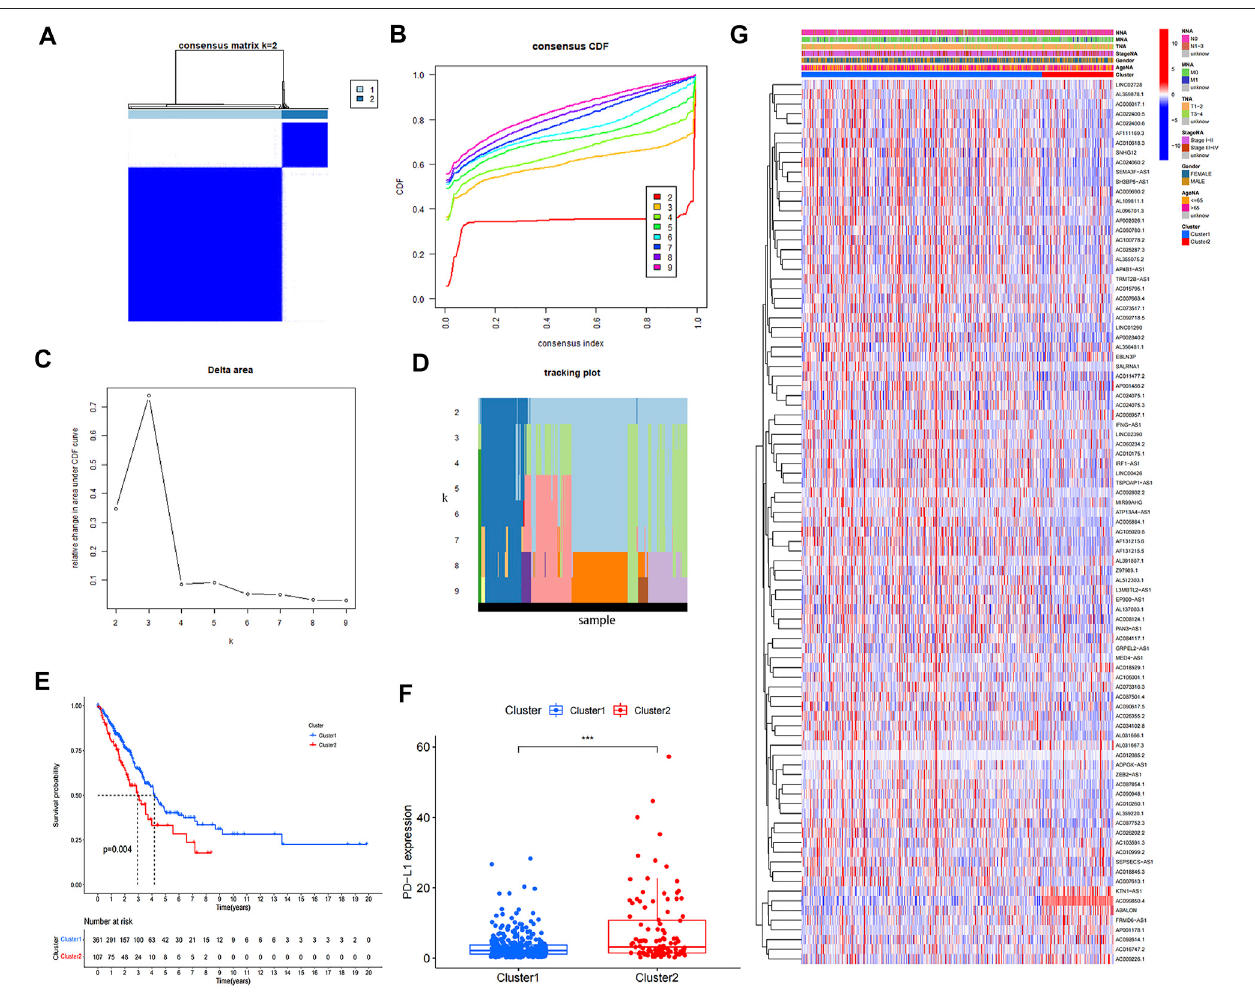
FIGURE 2 | Consensus clustering of prognostic m6A-related lncRNAs. (A) Consensus clustering matrix for k (cid:1) 2. (B – D) Consensus clustering cumulative distribution function (CDF) and relative change in area under CDF curve for k (cid:1) 2 – 9. (E) Kaplan – Meier curves for two clusters in LUAD. (F) Expression of PD-L1 in two clusters (* p < 0.05; ** p < 0.01; *** p < 0.001). (G) Heatmap of associations between expression levels of 91 prognostic m6A-related lncRNAs and clinicopathological features in the TCGA-LUAD